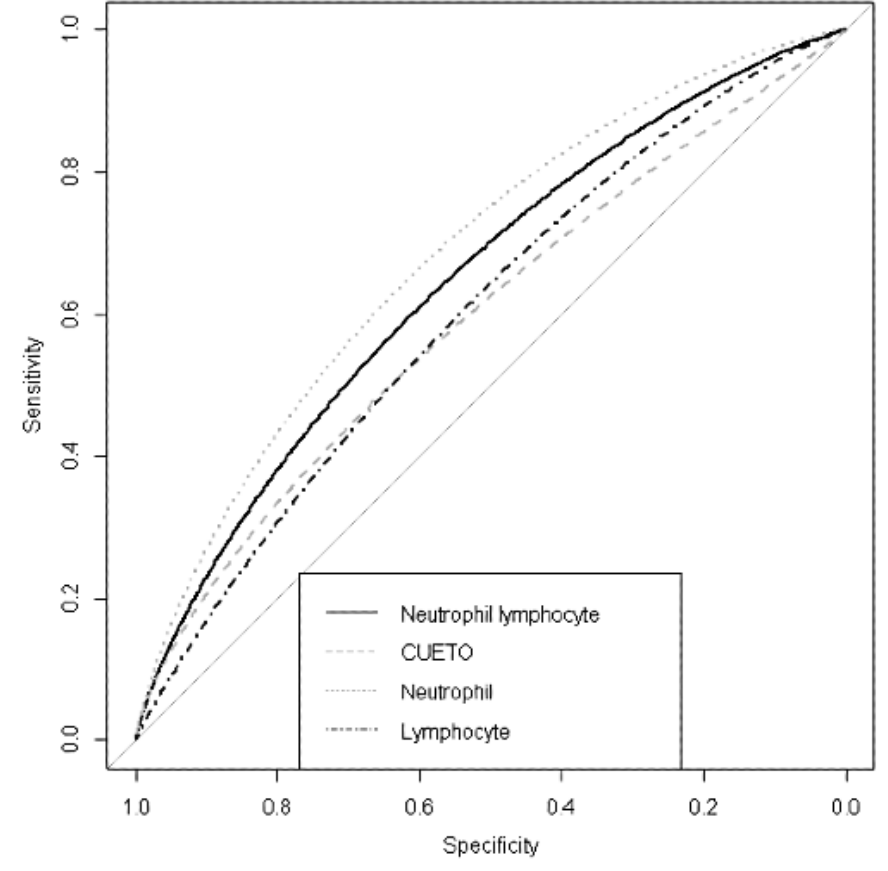
Figure 2. Area under the receiver operating characteristic curve for recurrence prediction. Time span: 1-180 days after bacillus Calmette-Guérin induction. CUETO: Club Urológico Español de Tratamiento Oncológico; Neutrophil: neutrophil count (differential); Lymphocyte: lymphocyte count (differential); Neutrophil Lymphocyte: derived neutrophil-to-lymphocyte ratio.